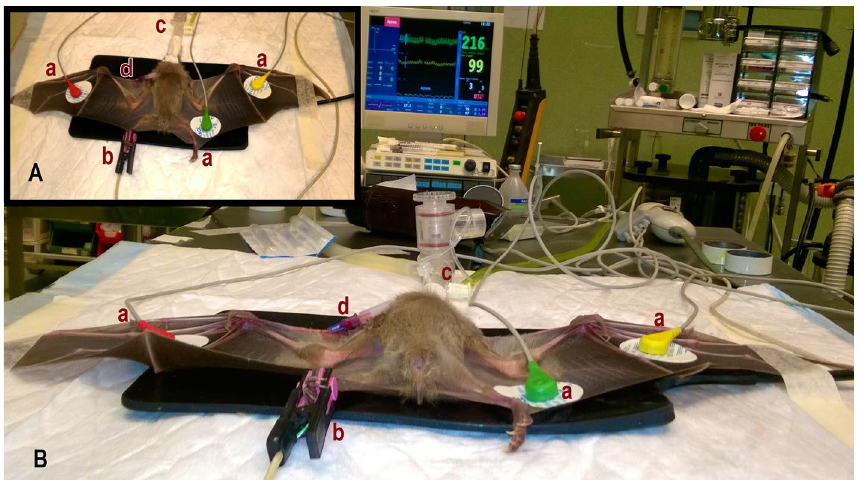
Figure 1. Egyptian fruit bat in dorsal recumbency, instrumented with monitoring devices ( A ) and overview in operating room ( B ). Disposable foam pad electrodes ( a ) positioned on the ventral aspect of wings for electrocardiographic measurements; pulse oximetry probe ( b ) placed on the right hind limb for haemoglobin saturation measurement; side-stream spirometer ( c ) attached to the facemask for multi gas analysis, and 22-gauge catheter ( d ) inserted in the left cephalic vein for collection of samples for blood gas analysis.